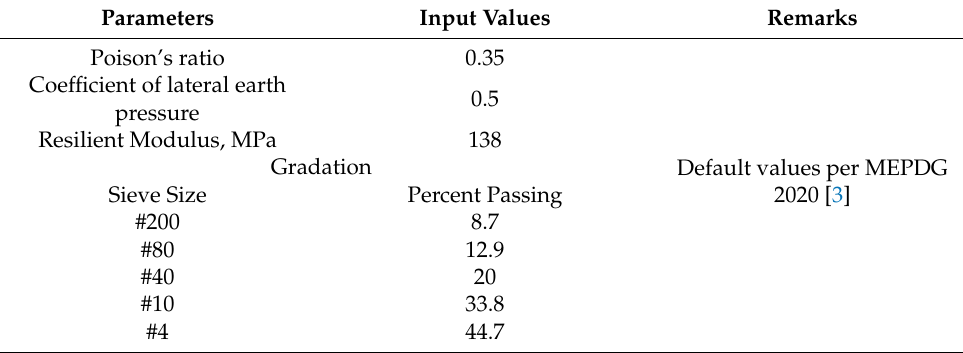
Figure 7. Pavement profile: ( a ) Laurens/SC-72, and ( b ) Pickens/SC-93 (figures are not drawn to scale). Table 4. Summary of material inputs for asphalt aggregate Table 3. Summary of material inputs for AASHTOWare PMED (v2.6.1).